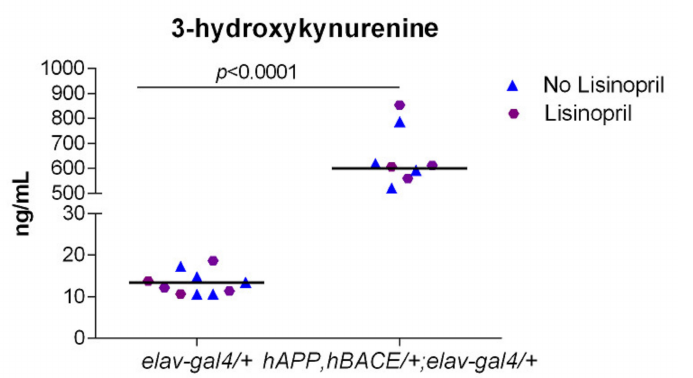
Figure 4. The kynurenine pathway metabolite 3-hydroxykinurenin (3-HK) is highly produced in AD flies. Concentrations of the neurotoxic 3-HK in the heads of hAPP , hBACE / + ; elav-gal4 / + AD flies were dramatically higher than in control flies, independently of whether flies were fed lisinopril on not. p -value obtained from Tukey–Kramer post hoc tests for multiple comparisons. Tryptophan levels were used as a covariate in the analysis. Data points show unadjusted